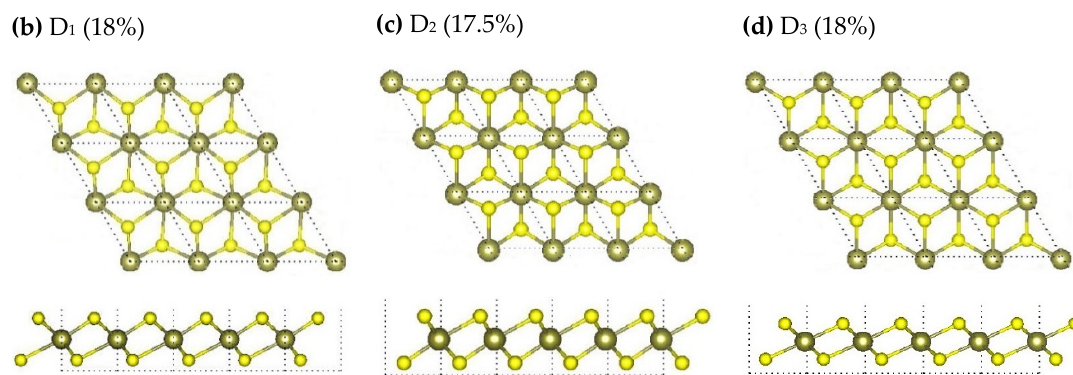
Figure 6. ( a ) The bandgap variations of the HfS 2 monolayer under uniaxial strain along x (D 1 ) and y (D 2 ) directions and the biaxial strains along x - y (D 3 ). ( b ) The deformed lattice structures of the HfS 2 monolayer at uniaxial 18% tensile strain along x direction (D1), ( c ) the deformed lattice structures of the HfS 2 monolayer at under uniaxial strains of 17.5% along y direction, and ( d ) the deformed lattice structures of the HfS 2 monolayer at 18% biaxial strain along x - y directions (D3). The top and side views are shown in the top and bottom panels, respectively.